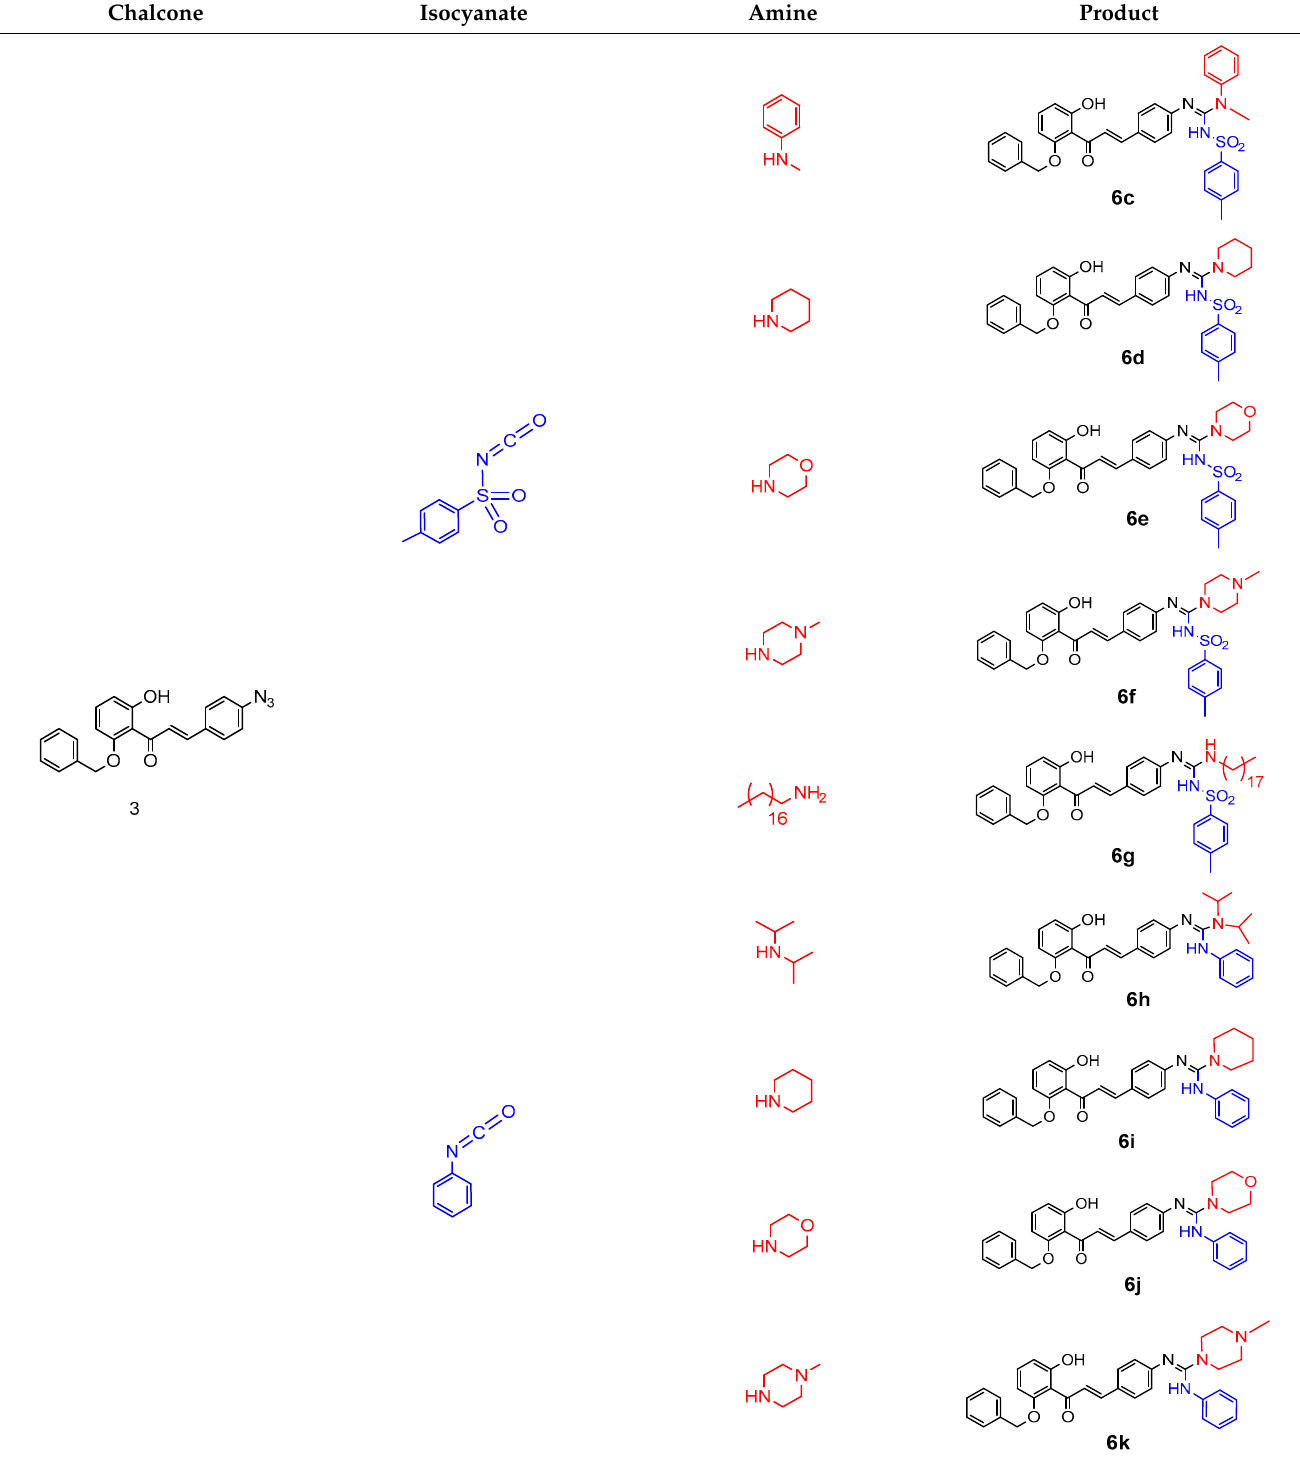
Table 1. Azidochalcone, isocyanates, and amines as starting reagents to generate the